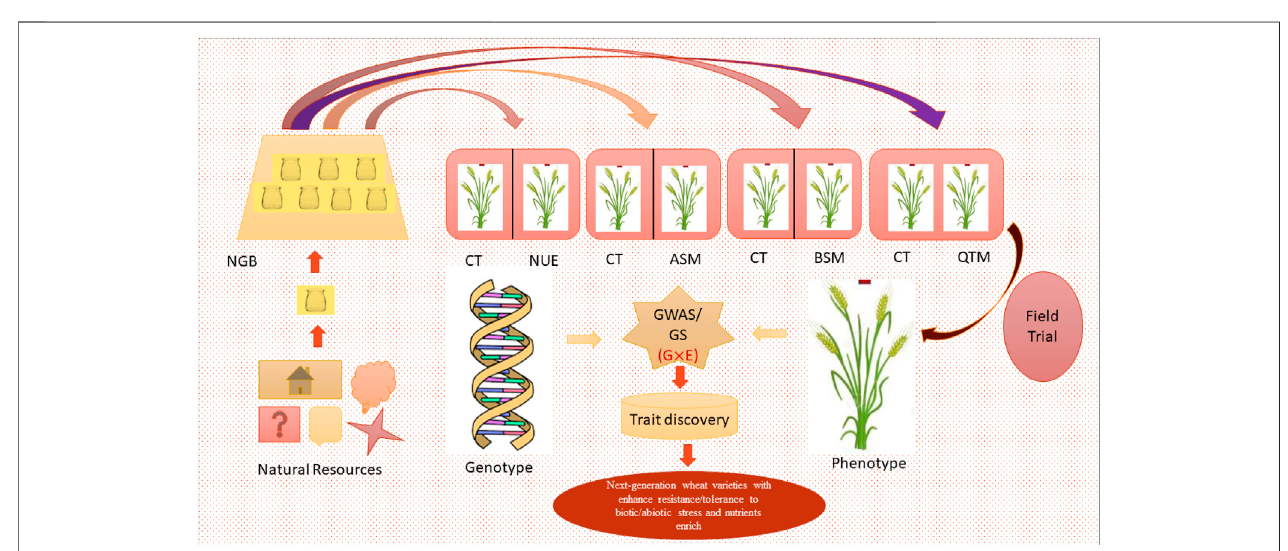
FIGURE 3 | Roadmap for germplasm assessment and trait discovery using integrated analysis of the genotype and phenotype (NGB — National Gene Bank; CT — control; NUE — nutrient-use ef fi ciency; ASM — abiotic stress measurement; BSM — biotic stress measurement; QTM — quality trait measurement; GWAS/ GS — genome-wide association study/genomic